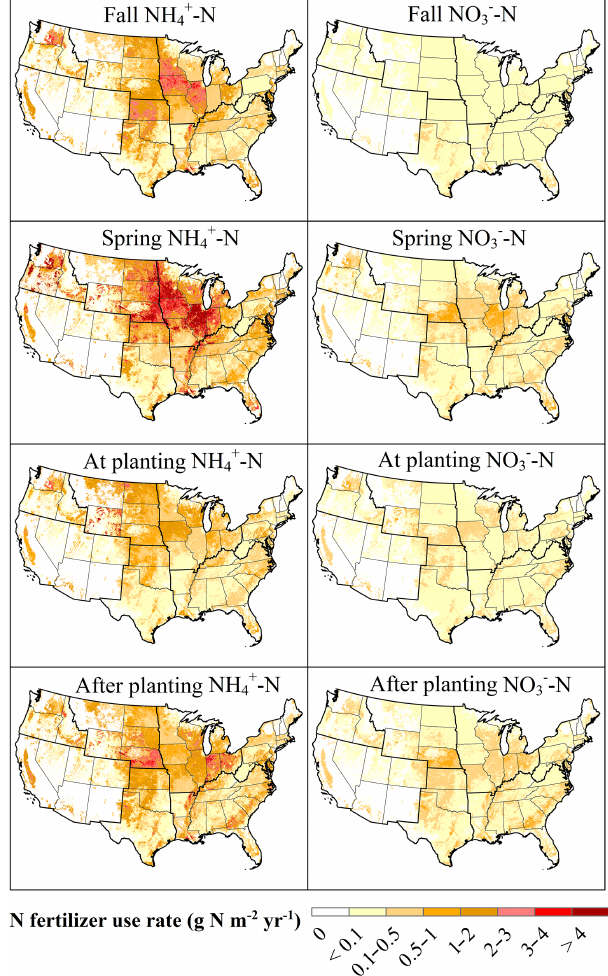
+ -N and NO − -N application 4 3